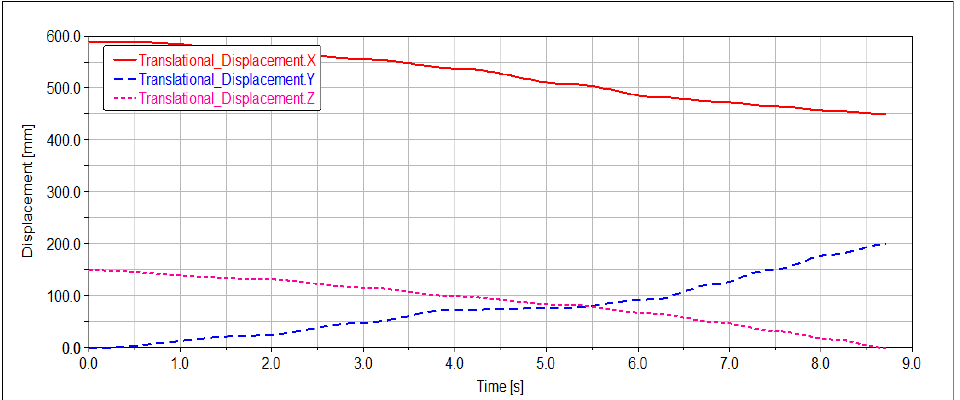
Figure 15. The displacement curve of the end-effector after trajectory optimization.